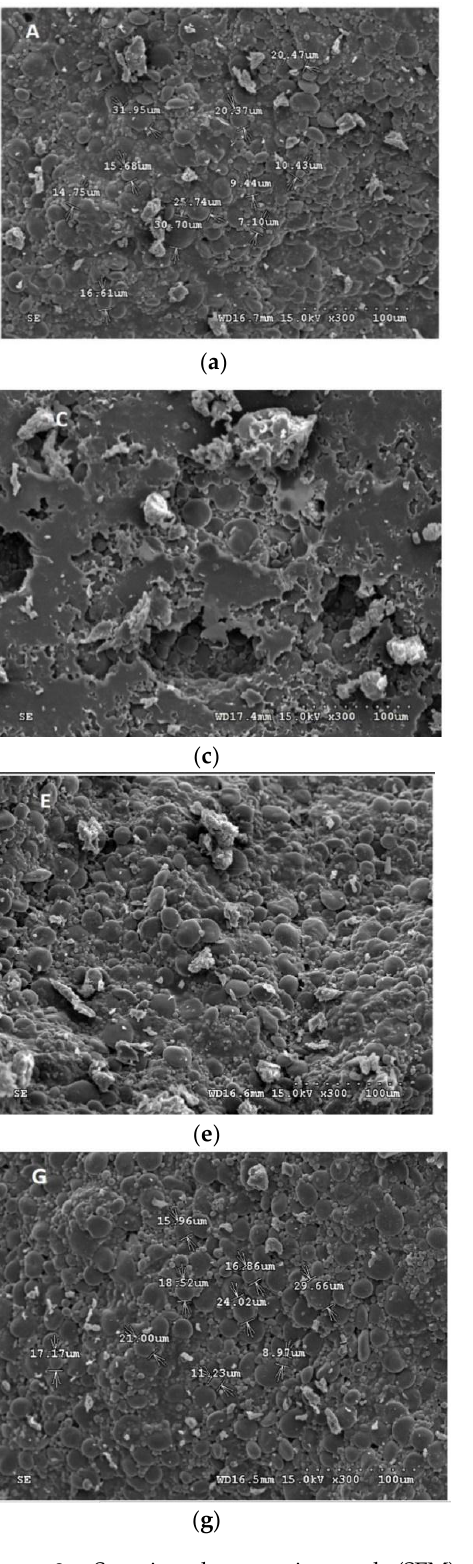
Figure 2. Scanning electron micrograph (SEM) of the encapsulated beads. ( a ) W. paramesenteroides -encapsulated arrowroot, ( b ) W. paramesenteroides -encapsulated maltodextrin, ( c ) L. paraplantarum - encapsulated maltodextrin, ( d ) L. paraplantarum -encapsulated arrowroot, ( e ) E faecalis -encapsulated arrowroot, ( f ) E faecalis -encapsulated maltodextrin, ( g ) L. plantarum -encapsulated arrowroot, and ( h ) L. plantarum -encapsulated maltodextrin.